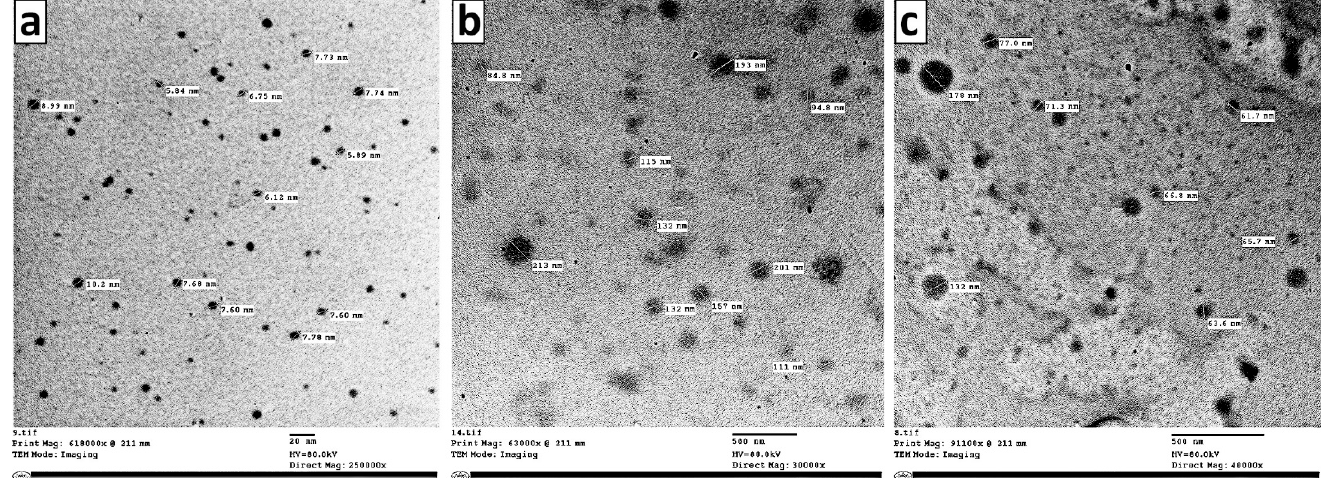
Figure 2. The transmission electron microscope (TEM) micrographs of ( a ) AgNPs, ( b ) carboxymethyl cellulose (CMC)-AgNPs, and ( c ) guar gum-AgNPs.